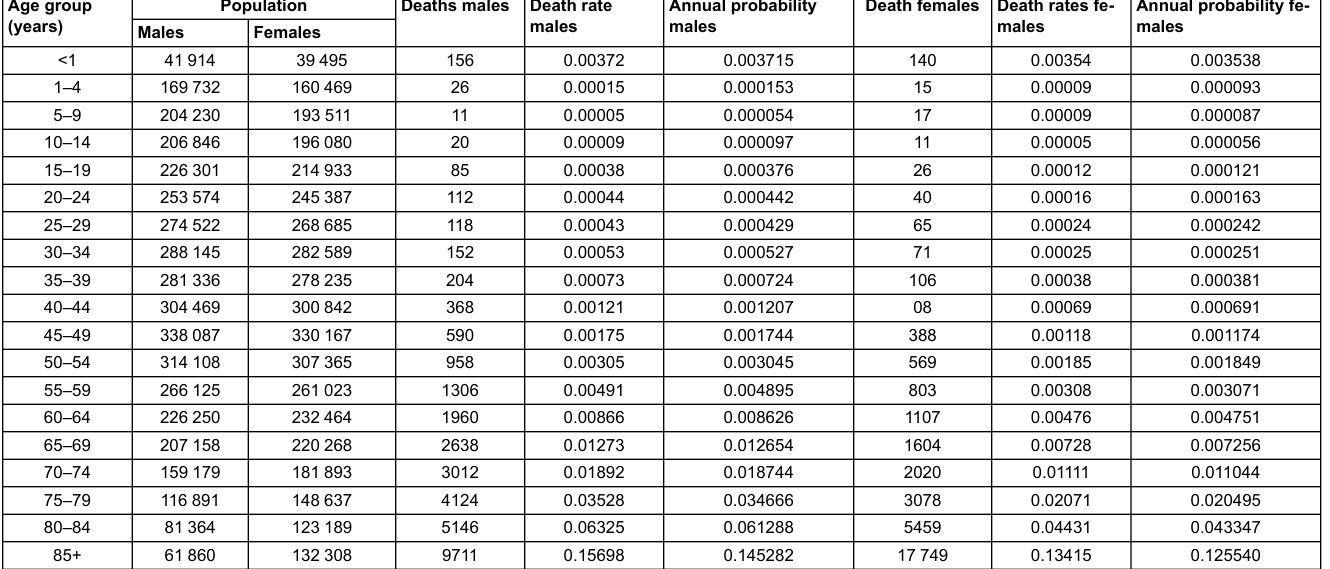
Table S4: All-cause mortality of the Swiss population in